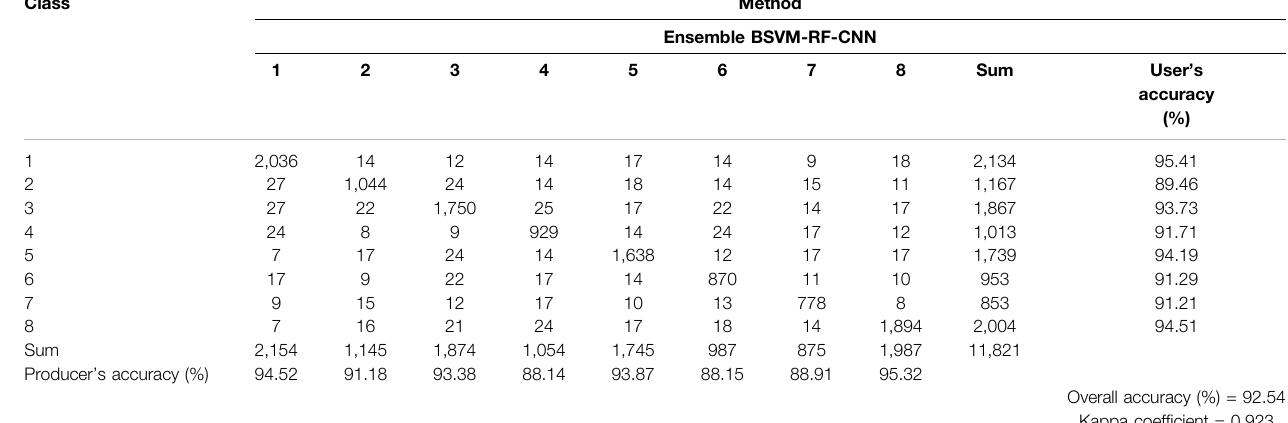
TABLE 6 | Confusion (error) matrix for ensemble BSVM-RF-CNN classi fi cation.